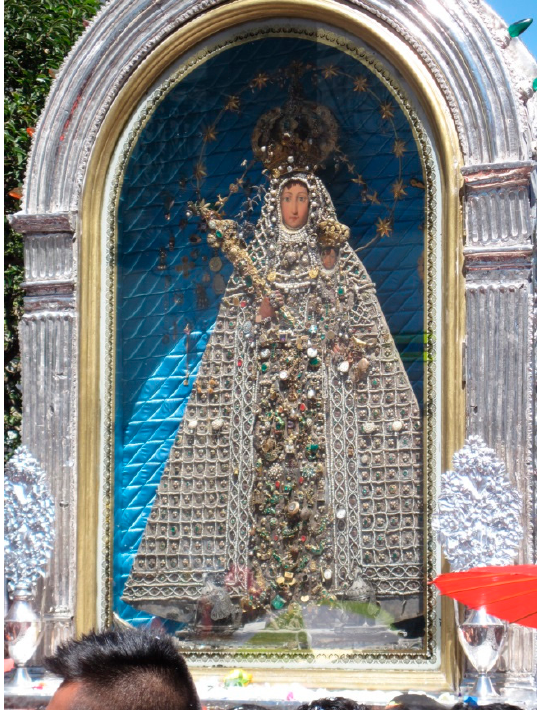
Figure 1. Devotional image of the Virgin of Guadlupe, Sucre (photo: Andrea Nicklisch).